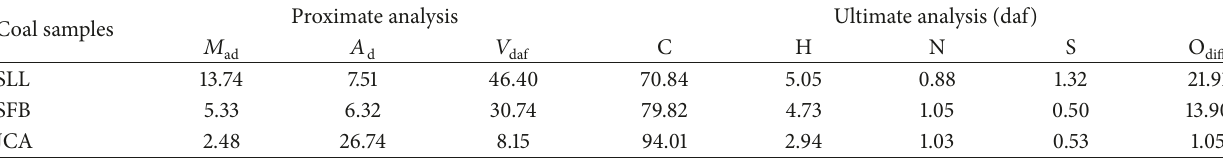
Table 1: Proximate and ultimate analyses ( 𝑊 %) of coal